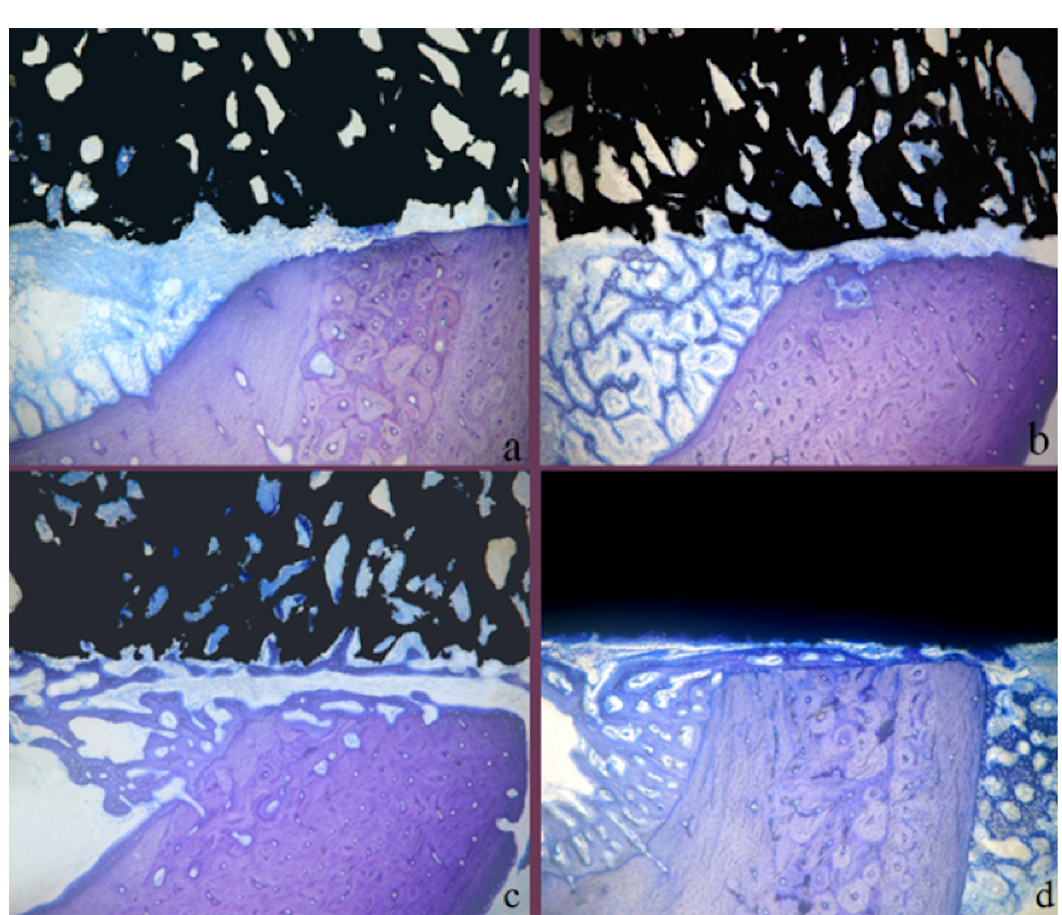
Figure 6. Initial periods at 1 week: a) panoramic vision at bone-implant interface without CaP coating (original magnification 50x); b) panoramic vision at bone-implant interface with CaP coating (original magnification 50x); at 2 weeks: c) panoramic vision at bone-implant interface without CaP coating (original magnification 50x); d) panoramic vision at bone-implant interface with CaP coating (original magnification